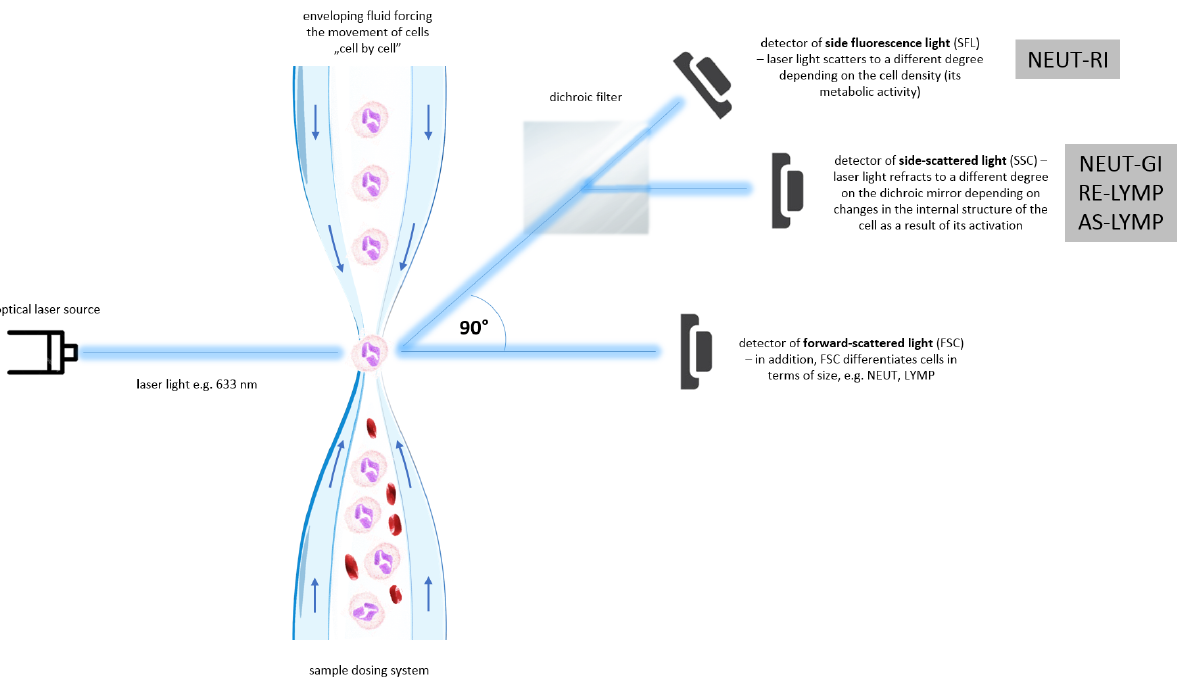
Figure 1. Extended Inflammation Parameters (EIP) measurement method. See references in main text. (AS-LYMP–Antibody-Secreting Reactive Lymphocytes, FSC–Forward-Scattered Light, LYMP–Lymphocytes, NEUT–Neutrophils, NEUT-GI–Neutrophil Granularity Intensity, NEUT-RI–Neutrophil Reactive Intensity, RE-LYMP–Reactive Lymphocytes, SFL–Side Fluorescence Light, SSC–Side-Scattered Light).